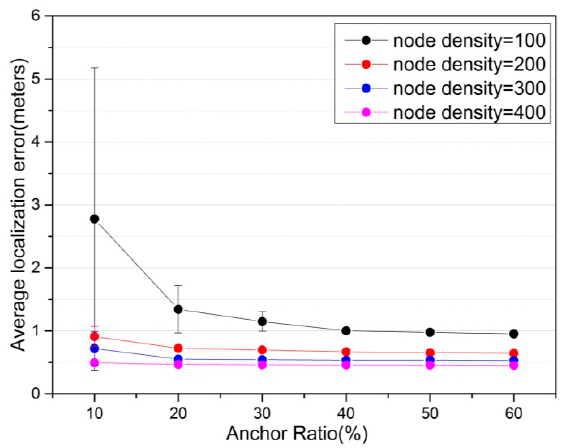
Figure 3. The effect of anchor ratio on average localization error. In addition, error bar represents 95% confidence interval of average localization error.